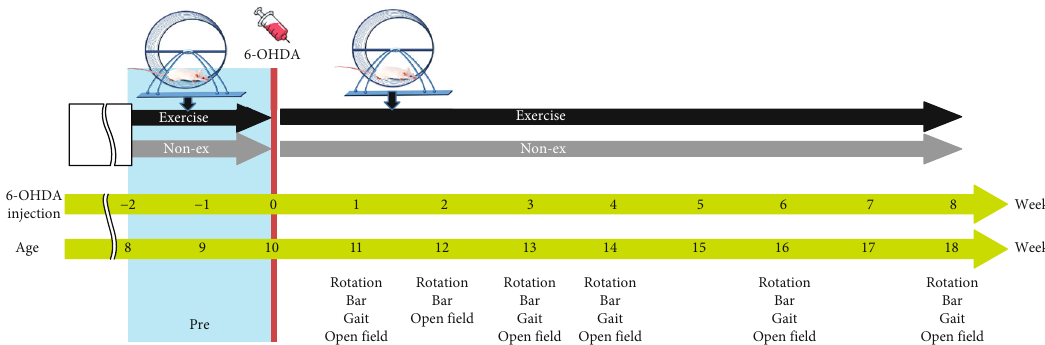
Figure 1: Study design for long-term e ff ects of exercise training in 6-OHDA-induced PD rats. The performance of exercise intervention and sham control rats was assessed every day before the PD lesion and also after 8 successive weeks. Behavioral tests including the rotational behavior test, bar test for akinesia, gait test, and open- fi eld test were performed to investigate time course treatment e ff